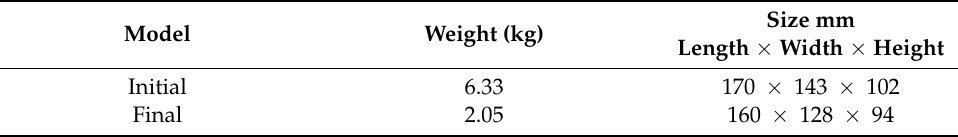
Table 3. Parameters of the initial model and final model of the swing micro-mirror structure.